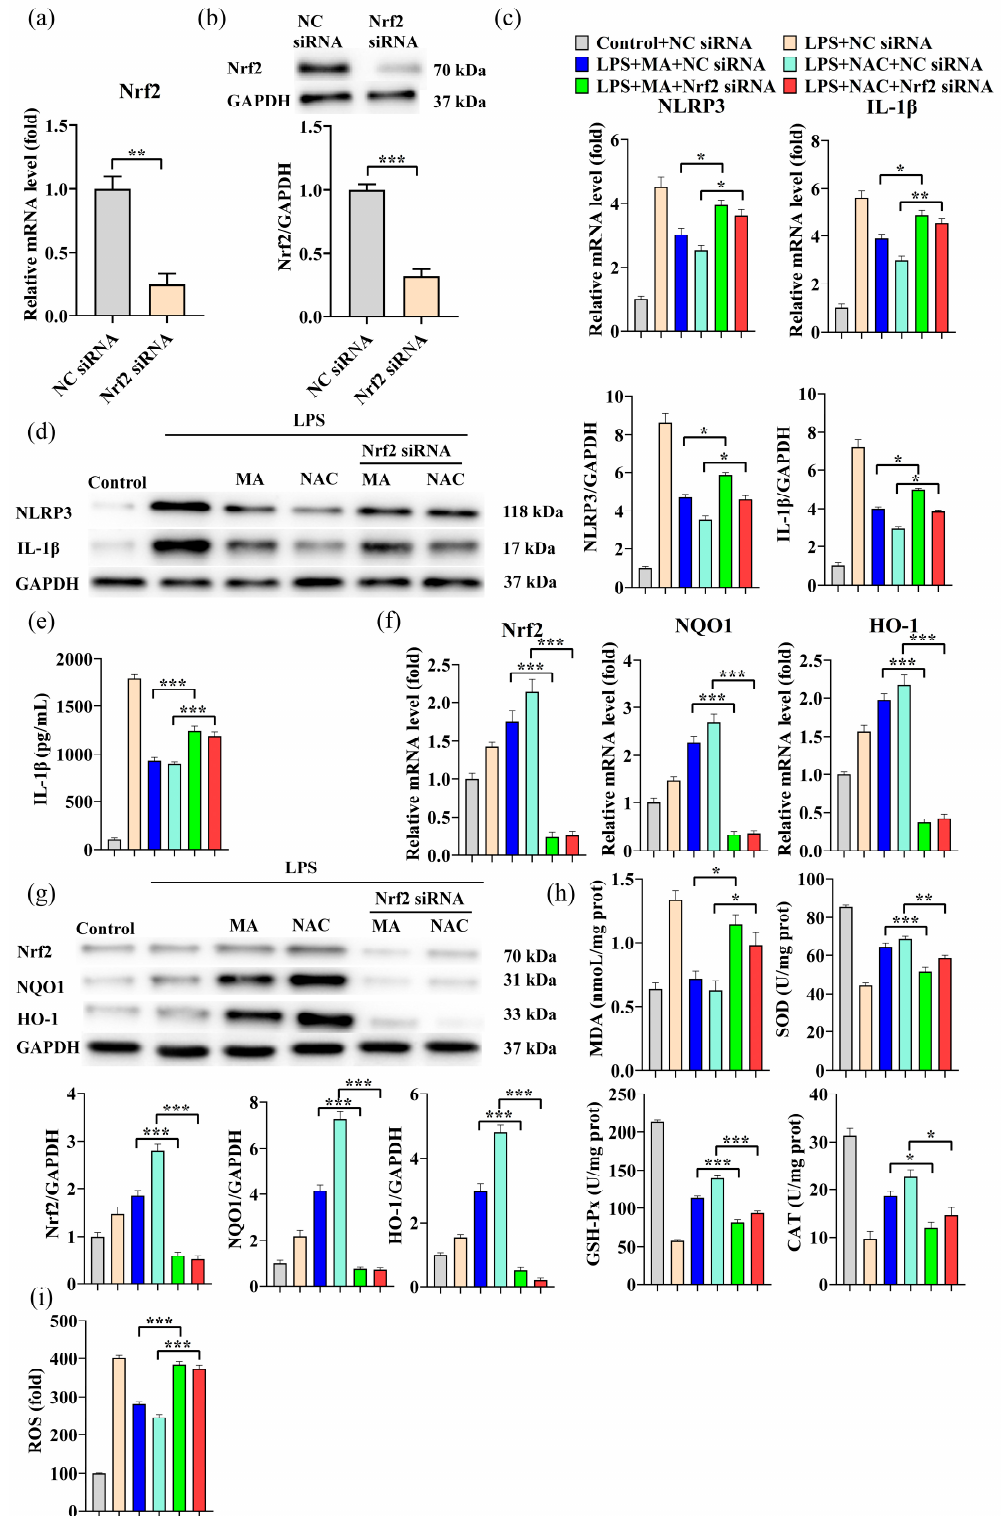
Figure 5. MA attenuates the inflammatory effects induced by LPS through the NLRP3/IL-1 β signaling pathway by activating the Nrf2 antioxidant pathway. Cells were first transfected with siRNA for 48